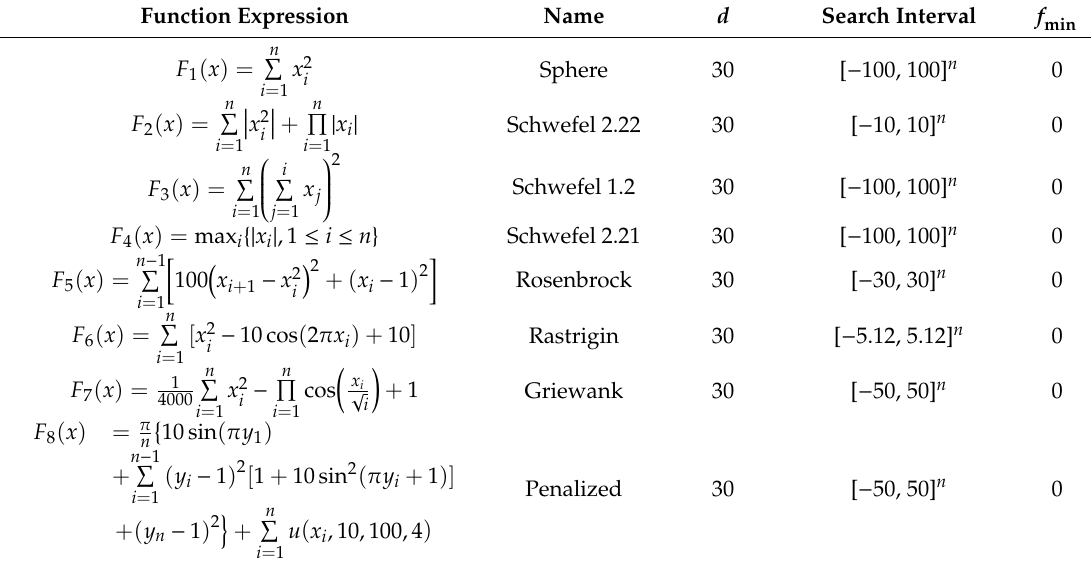
Table 2. Benchmark functions.